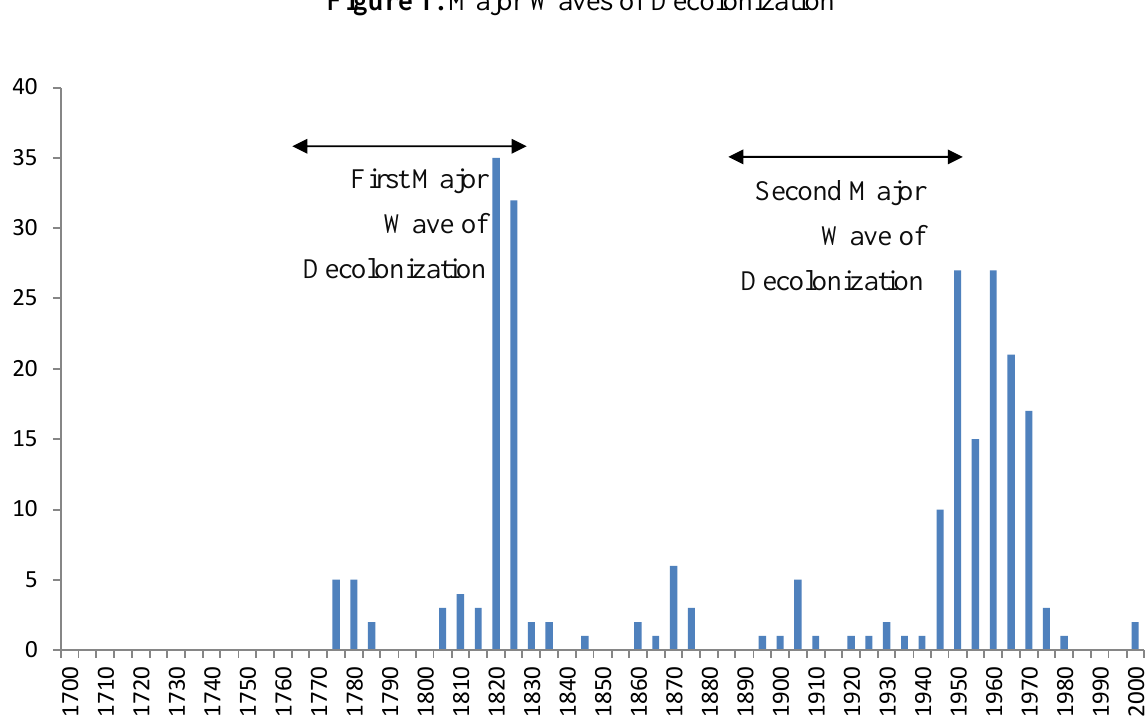
Figure 1. Major Waves of